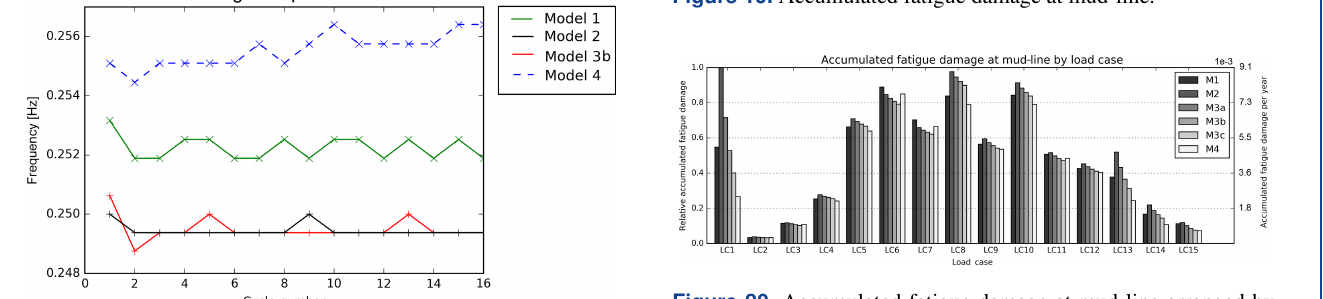
Figure 20. Accumulated fatigue damage at mud-line arranged by load